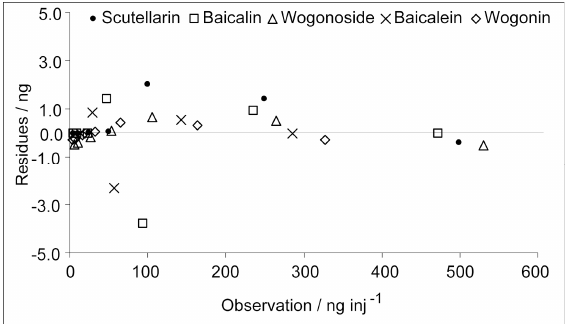
Figure 5. Residues of the calibration curves of the five analytes. The observation represents the amounts of the analytes introduced into the instrument for analysis. Residue is the difference between the observation and the fitted value, which is calculated from the average detector response. The maximum values of scutellarin, baicalin and wogonoside were approximately 500 ng·inj − 1 ; those of baicalein and wogonin were approximately 300 ng·inj − 1 . Table 2. Linearity, limits of detection and limits of quantification of the HPLC procedure ( n = 3).